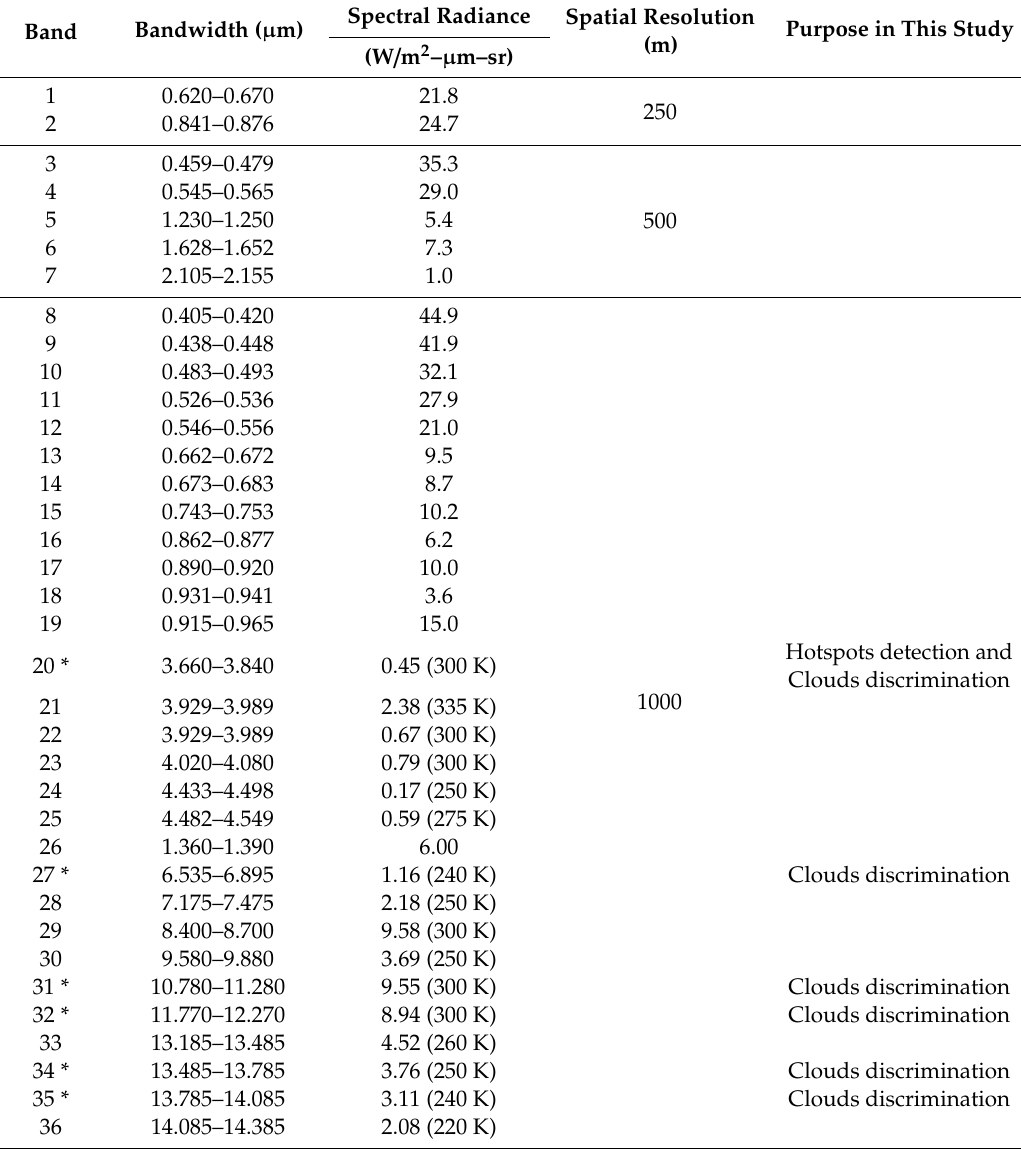
Table 1. MODIS (MODerate-resolution Imaging Spectroradiometer)